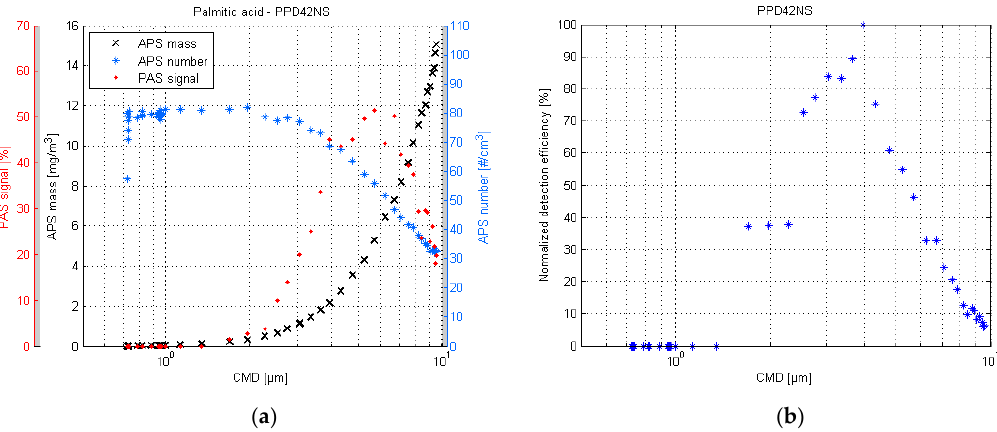
Figure 5. APS number distribution of the palmitic acid test ( a ) and the respective geometric standard deviation plot ( b ).